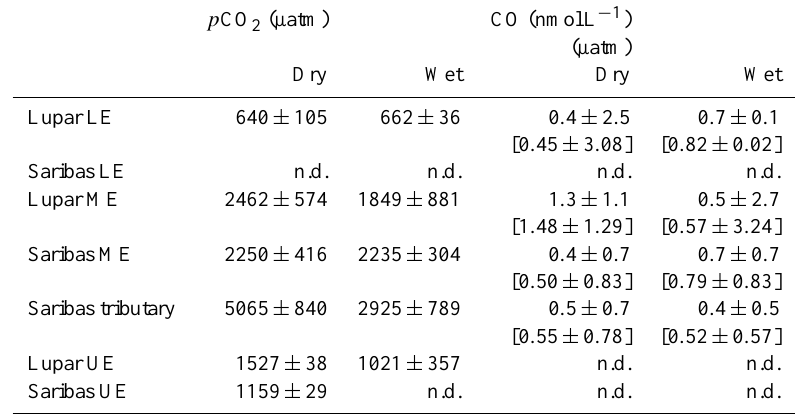
Table 2. Median CO 2 partial pressures and CO concentrations (and partial pressures in brackets), respectively. p CO 2 (µatm) CO (nmolL − 1 ) (µatm) Dry Wet Dry Wet Lupar LE 640 ± 105 662 ± 36 0 . 4 ± 2 . 5 0 . 7 ± 0 . 1 [0 . 45 ± 3 . 08] [0 . 82 ± 0 . 02] Saribas LE n.d. n.d. n.d. n.d. Lupar ME 2462 ± 574 1849 ± 881 1 . 3 ± 1 . 1 0 . 5 ± 2 . 7 [1 . 48 ± 1 . 29] [0 . 57 ± 3 . 24] Saribas ME 2250 ± 416 2235 ± 304 0 . 4 ± 0 . 7 0 . 7 ± 0 . 7 [0 . 50 ± 0 . 83] [0 . 79 ± 0 . 83] Saribas tributary 5065 ± 840 2925 ± 789 0 . 5 ± 0 . 7 0 . 4 ± 0 . 5 [0 . 55 ± 0 . 78] [0 . 52 ± 0 . 57] Lupar UE 1527 ± 38 1021 ± 357 n.d. n.d. 1159 ± 29 n.d. n.d.